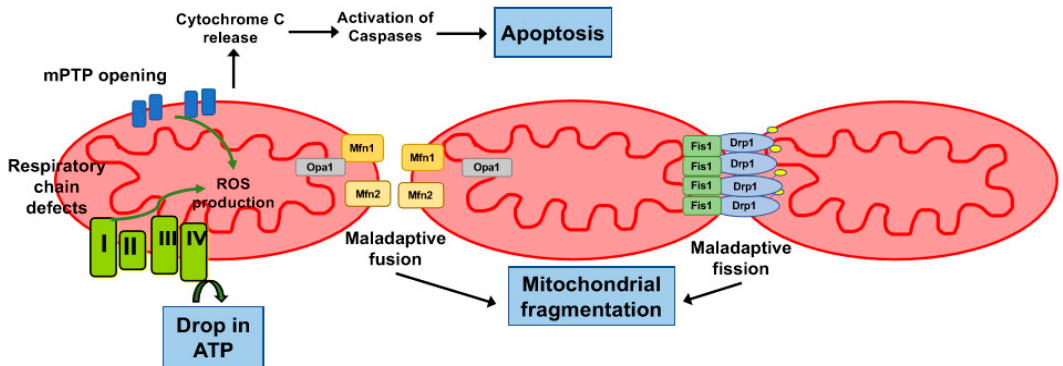
Figure 1. Mitochondrial dysfunction in cardiomyocytes in sepsis and cardiac arrest. Defects in